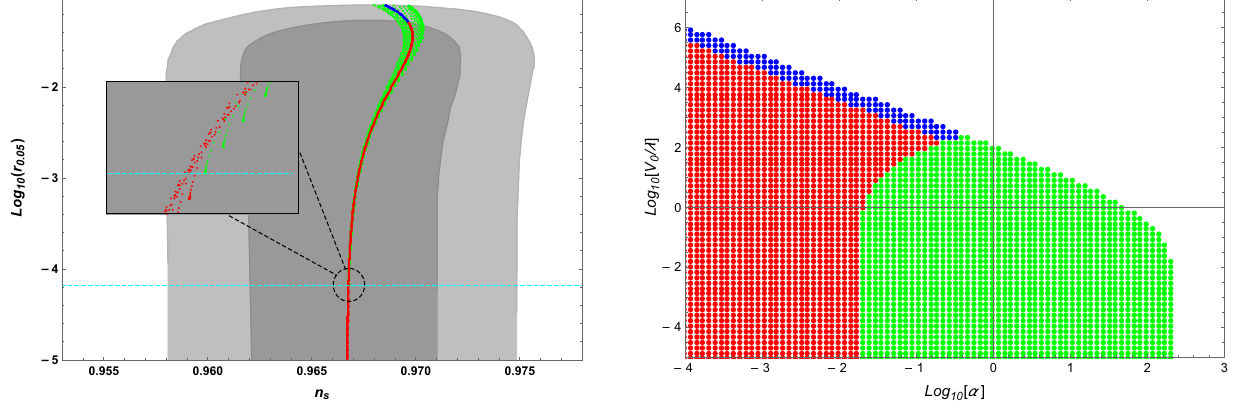
regions circled in the figure. The right panel show the constraints on the parameters α and V 0 /λ , the red points are within 1 σ region while blue points are within 2 σ but outside the 1 σ bounds. The green points are excluded due to super-Planckian field excursion (cid:6)φ >